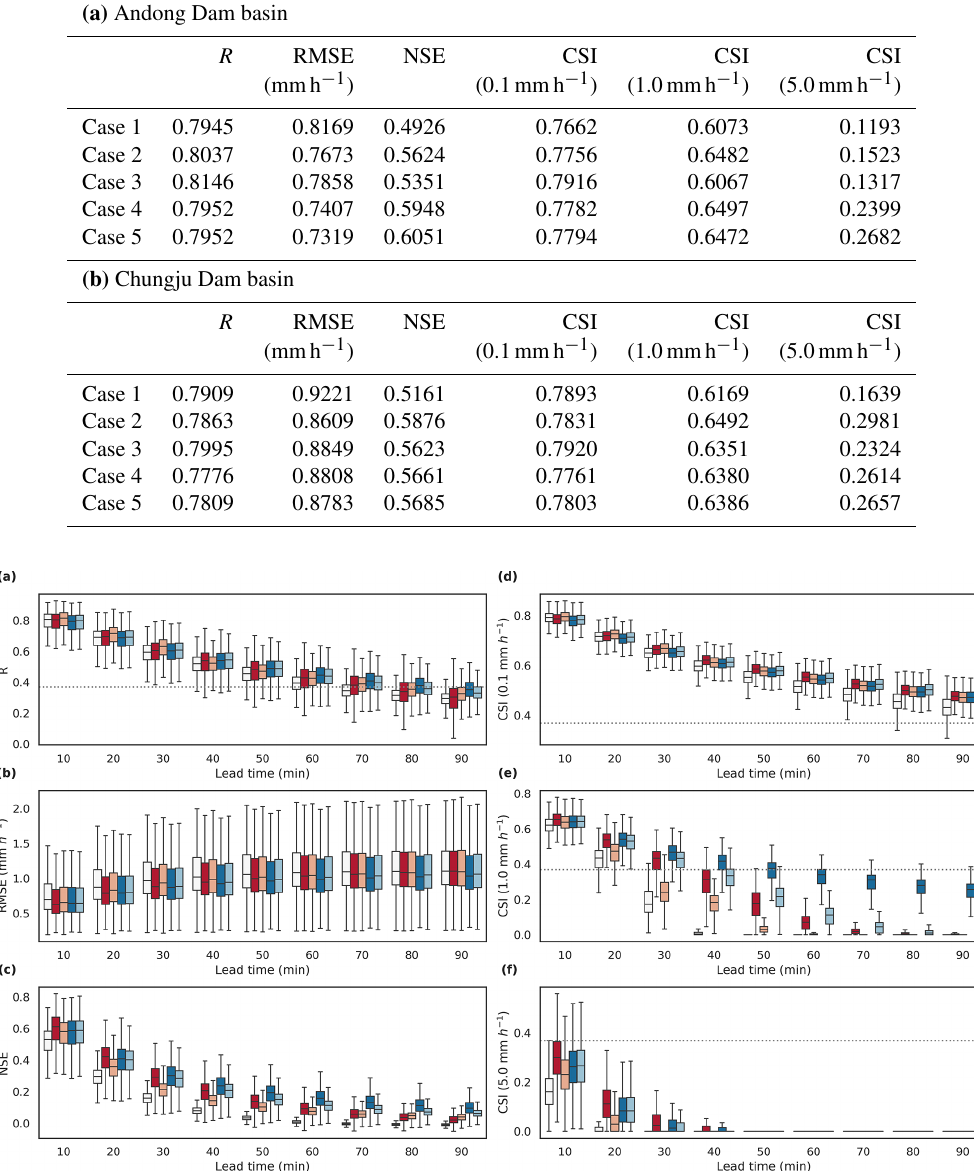
Table 5. Comparison of the average values of the verification metrics for the 10min precipitation prediction of the five different models using different transfer learning strategies for the (a) Andong Dam and (b) Chungju Dam basins in summer (June–August) 2018.